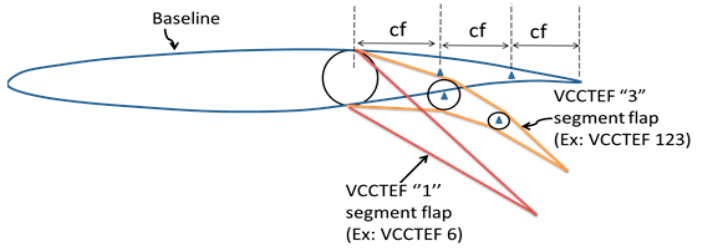
Figure 4. Schematic of VCCTEF 3 and 1 segment flap.